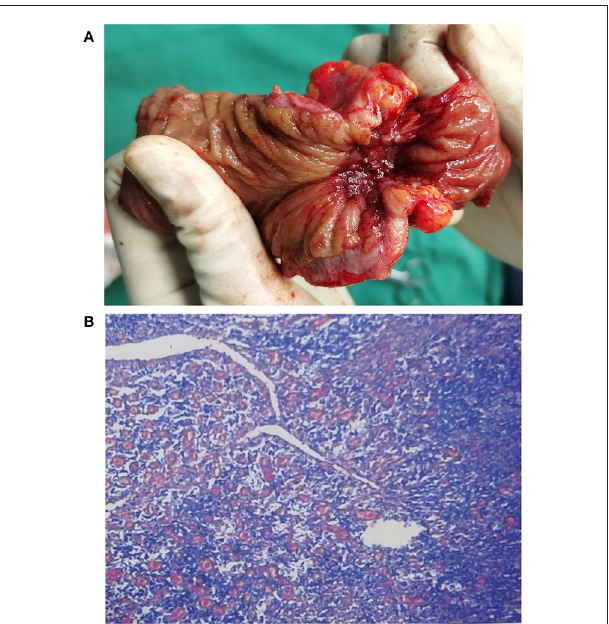
FIGURE 4 | (A) An isolated, well-circumscribed ileocecal ulcer could be seen in the surgical specimen; (B) The post-operative pathological analysis revealed chronic non-specific inflammation (hematoxylin and eosin, original magnification 20 ×